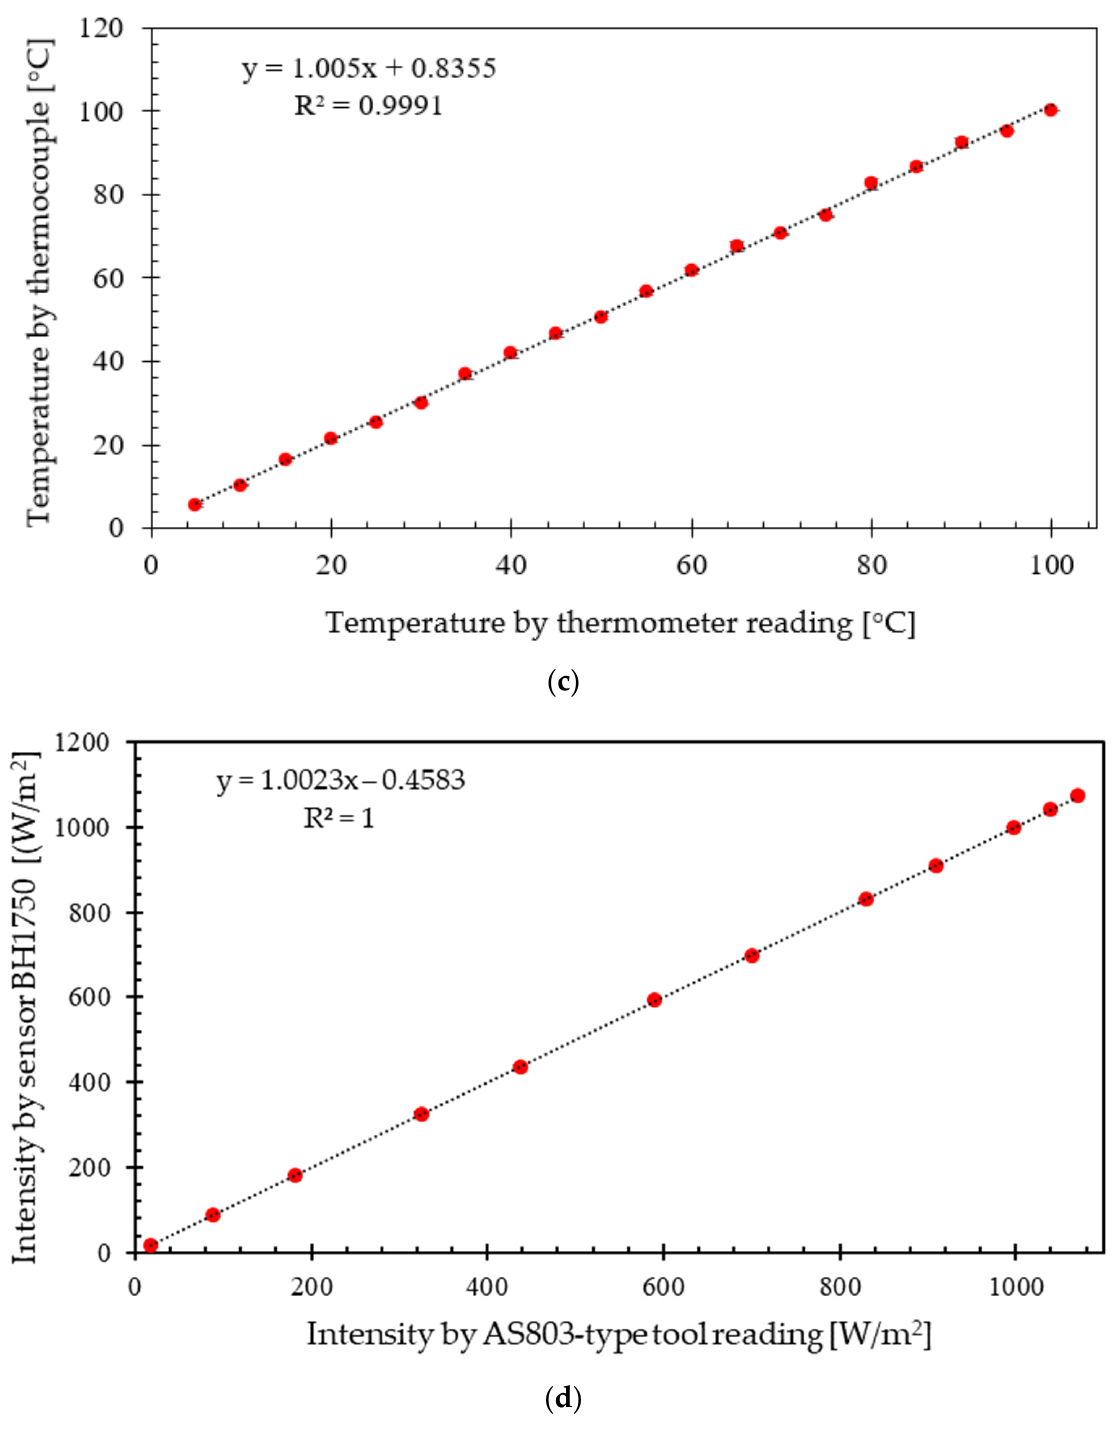
Figure 6 . The calibration of tools used to measure ( a ) altitude–azimuth angles, ( b ) solar radiation intensity, ( c ) temperature, and ( d ) electrical power .